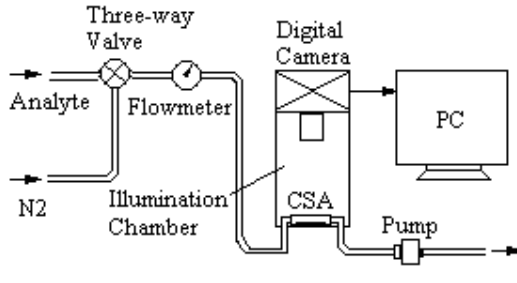
Figure 3. Schematic of colorimetric sensor for amines discrimination and